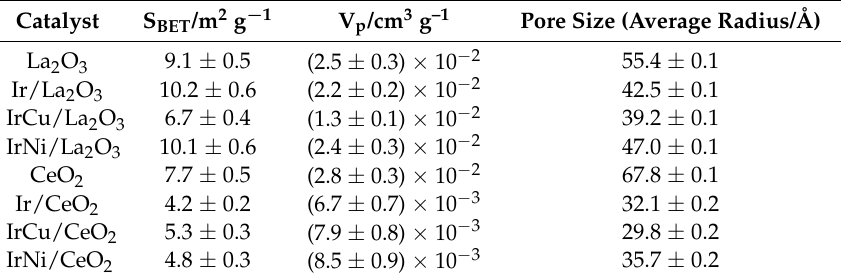
Table 1. Textural properties of catalysts and